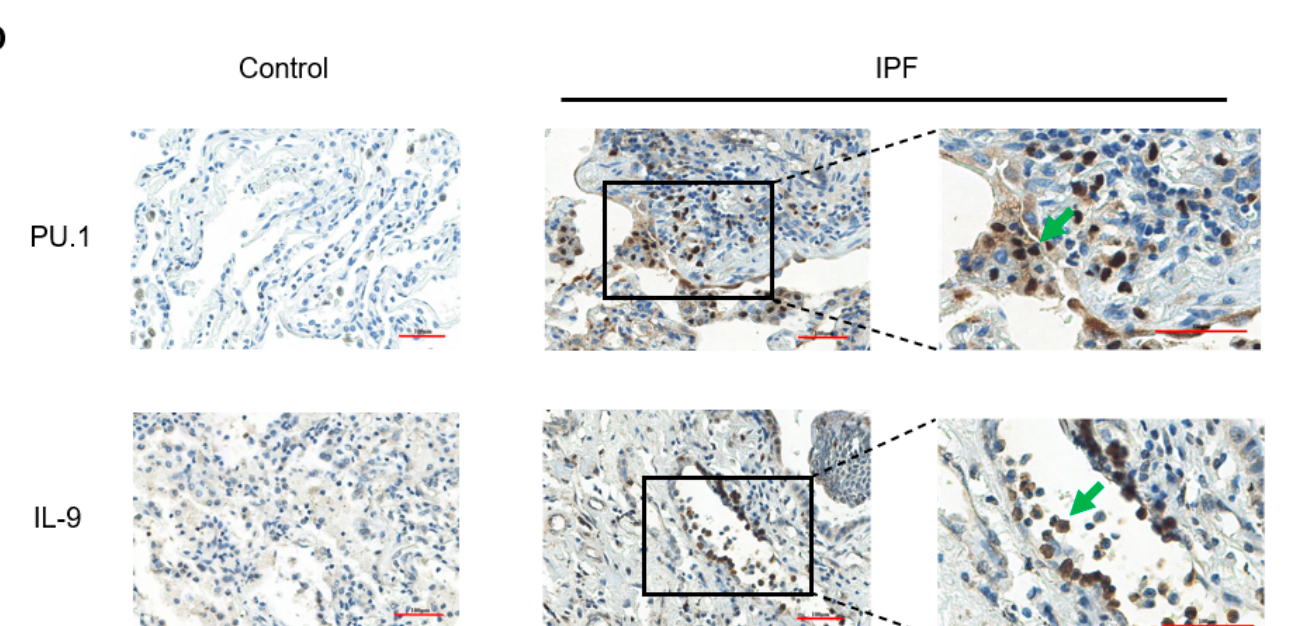
Figure 1. Increased Th9 cell differentiation and IL-9 expression in patients with IPF. ( A ) Representative pseudo-color plot showing proportion of Th9 cells to CD4 + T cells in PBMC of patients with IPF and healthy controls by flow cytometry. ( B ) Proportions of Th9 cells to CD4 + T cells in PBMC between patients with IPF ( n = 16) and healthy controls ( n = 19). ( C ) Correlation analysis between proportion of Th9 cells in PBMC and HRCT score of pulmonary fibrosis ( n = 16). ( D ) Representative images of PU.1 and IL-9 immunostaining in serial sections of lung tissue from patients with IPF ( n = 14) and controls ( n = 4). Scale bars, 100 µ m. PBMC, peripheral blood mononuclear cell. HRCT, high resolution CT. *** p < 0.001.